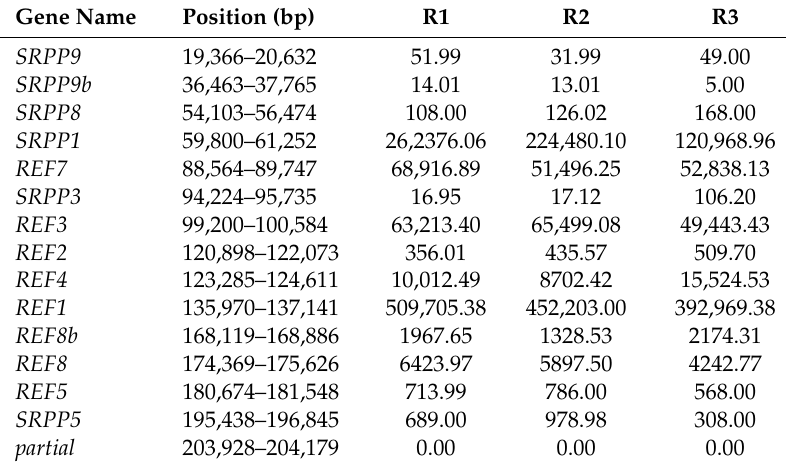
Table 2. Normalized read counts for REF and SRPP transcripts present on scaffold 1222 from latex of clone PB 260 calculated from RNA-seq data for three independent biological replications on healthy trees